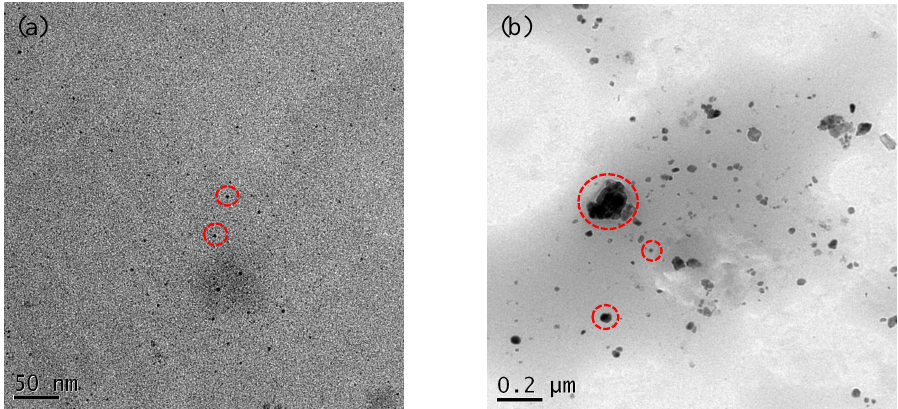
Figure 5. UV-Vis spectrums of Ag1/80S; and Ag10/80S.